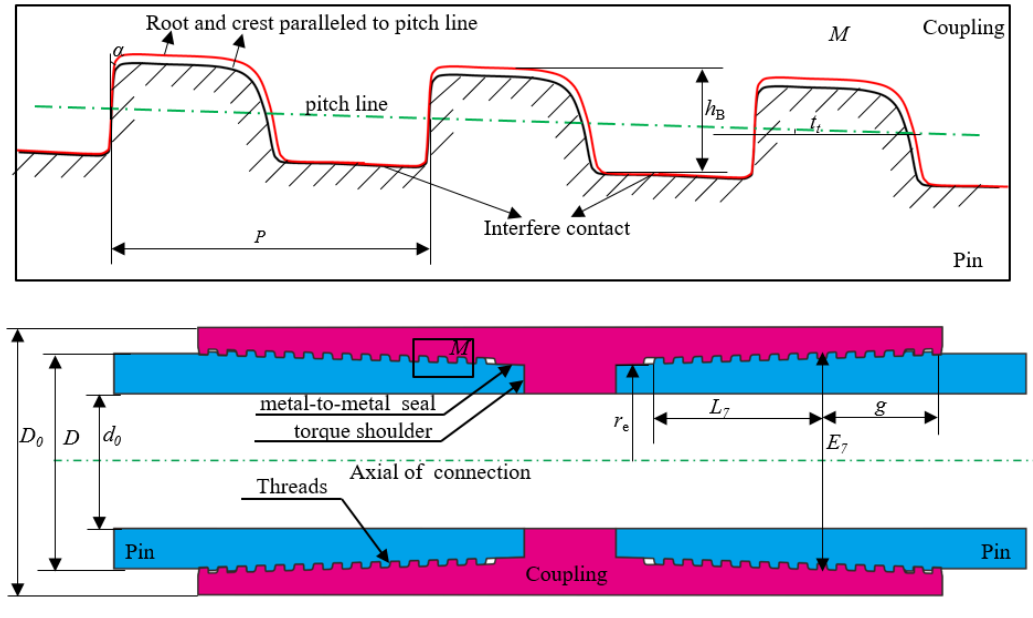
Figure 1. The schematic diagram of a premium connection.